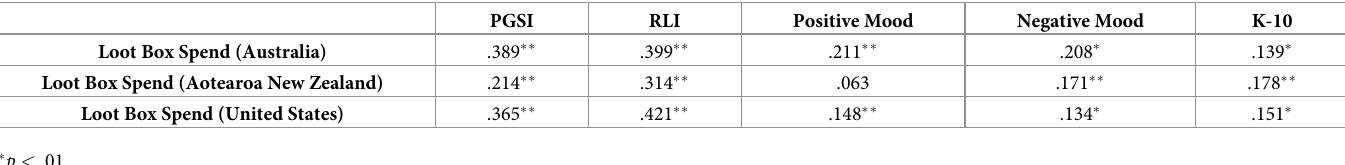
Table 3. Relationships (Spearman’s rho) between impulse control disorders: Problem Gambling Symptomology (PGSI), the Risky Loot Box Index (RLI), positive and negative mood (PANS-SF) and IGD symptomology, split by